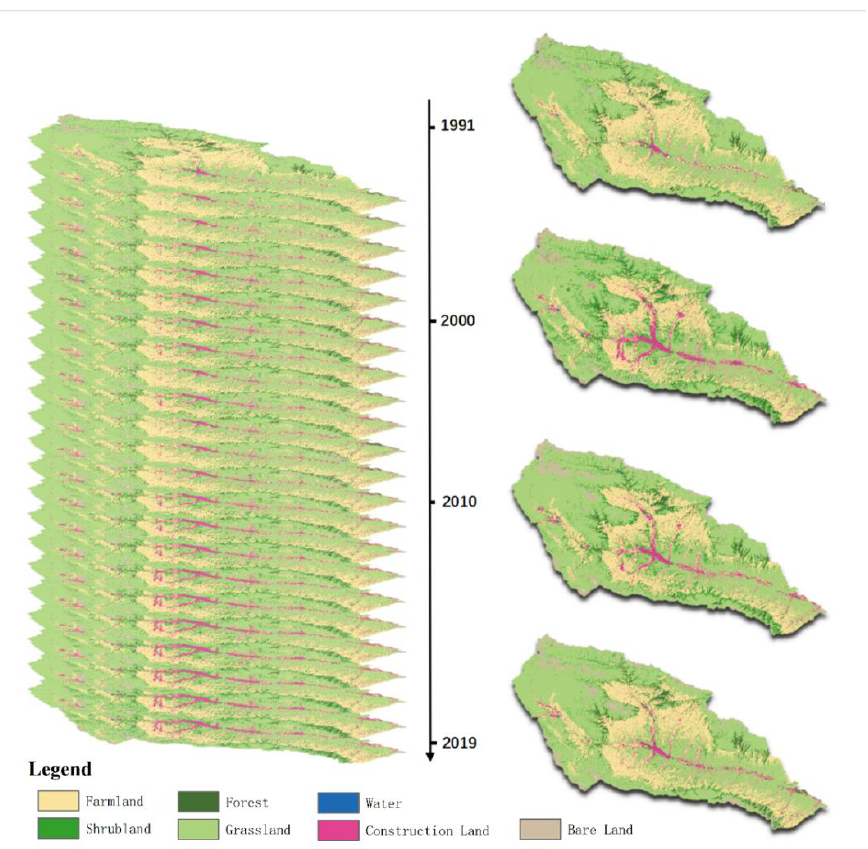
Figure 3. Results of year-by-year land use function classification from 1990 – 2019.